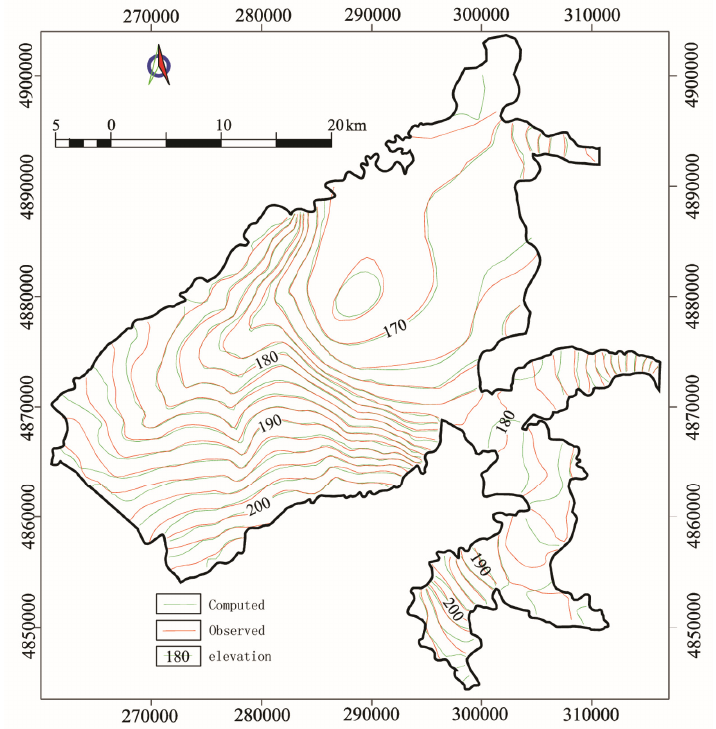
Figure 11. Comparison of observed and computed groundwater contour